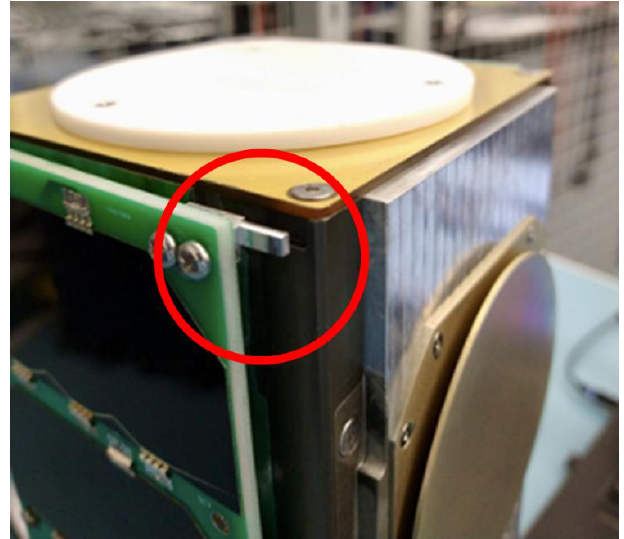
Figure 15. The aluminum stopper at the edge of the warped solar panel was deflected by as much as 1 cm, increasing the risk of deployment failure due to cold welding or friction.